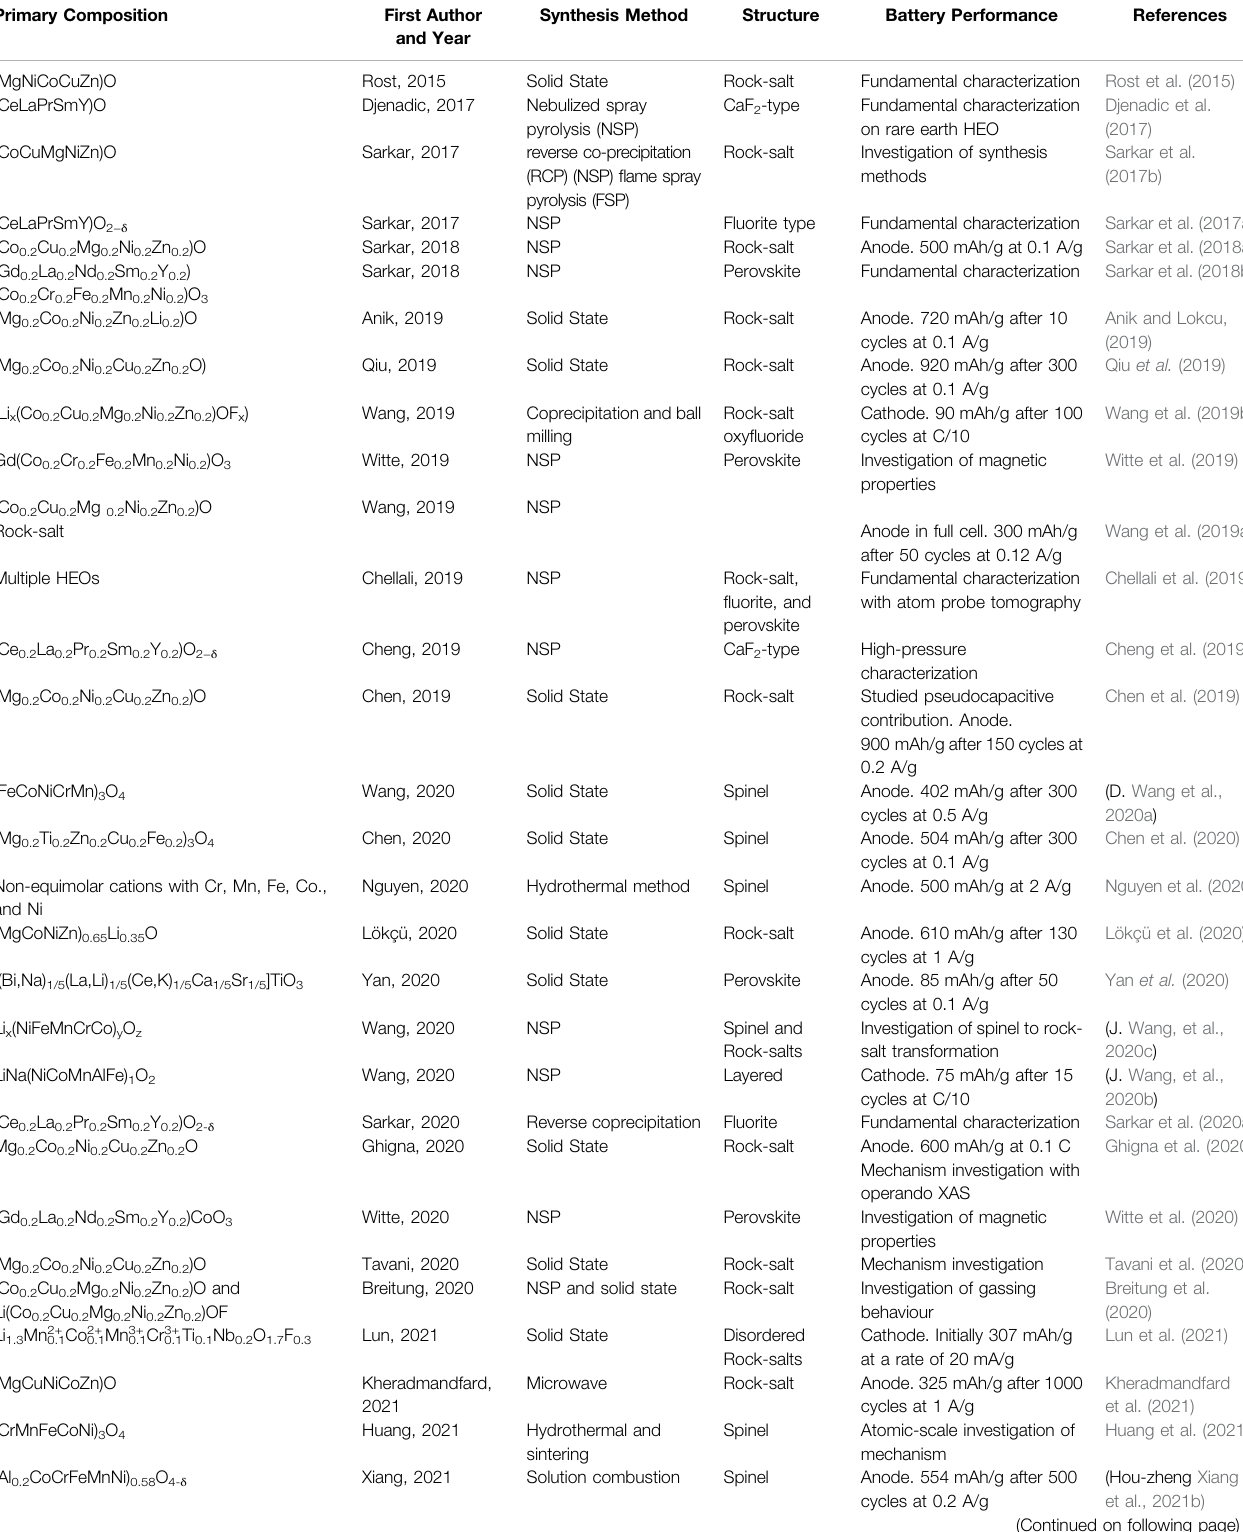
TABLE 1 | Select Publications on High-Entropy Oxides for Li-ion